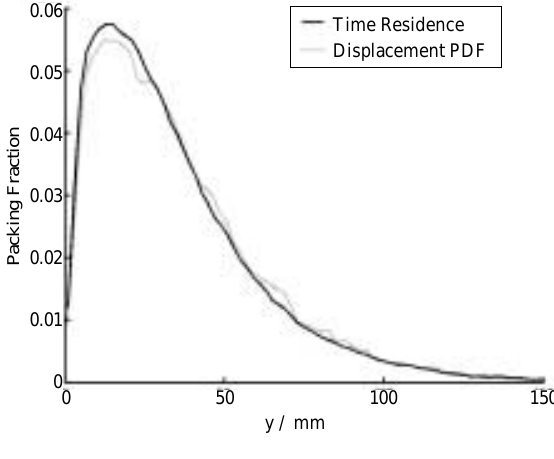
Comparison of the packing fraction profile determined from the displacement probability density (start height (cid:4) 22.5 mm) and one produced from the time residence dis- tribution of the particles. The two curves should in princi- ple be equivalent, though the time residence distribution gives a more accurate picture of the solids